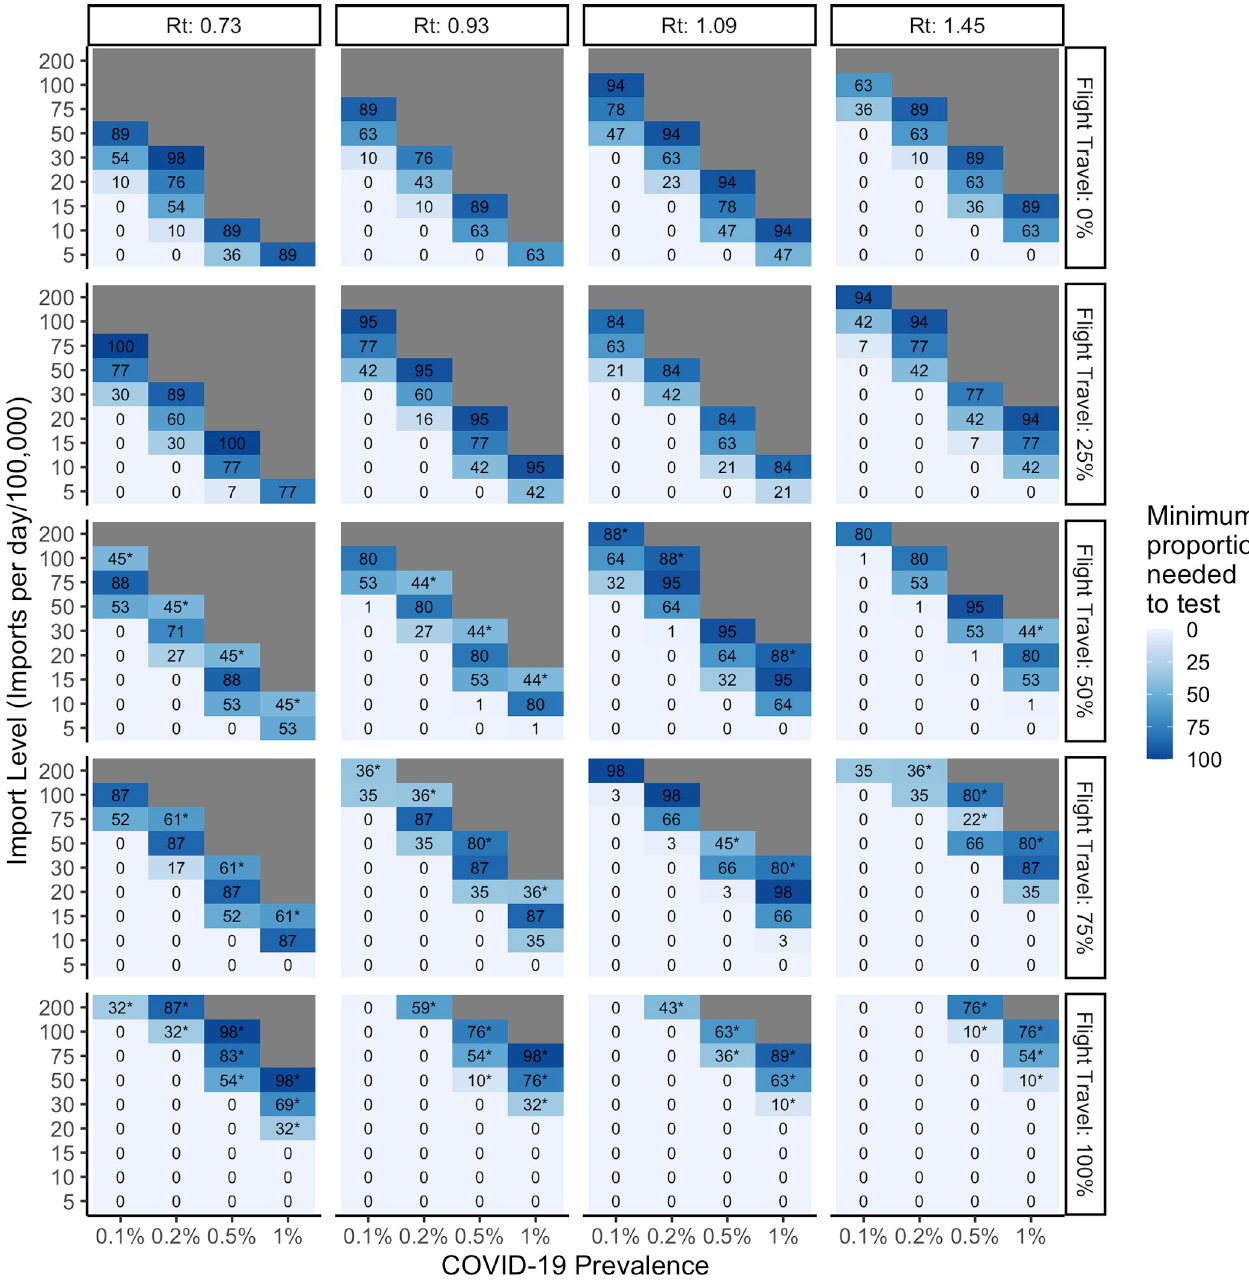
Fig 5. Impact of increasing proportion of flight travel when Ag-RDT screening is first fully saturated at land borders and additionally implemented for flight arrivals. Cells with an asterisk ( � ) represent the additional proportion of flight arrivals to be screened with SARS-CoV-2 Ag-RDTs following full saturation of land testing. Cells without an asterisk correspond to the minimum proportion of land arrivals required to be tested (Fig 2). Ag-RDT sensitivity is set to 71%.